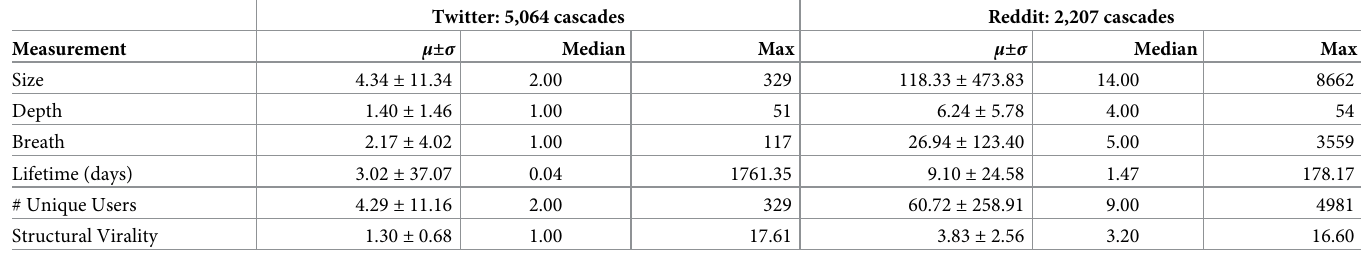
Table 3. Contrasting measurements of CVE-related discussion spread on Twitter versus Reddit. Average values are higher for Reddit compared to Twitter, but median and maximum values are significantly higher for